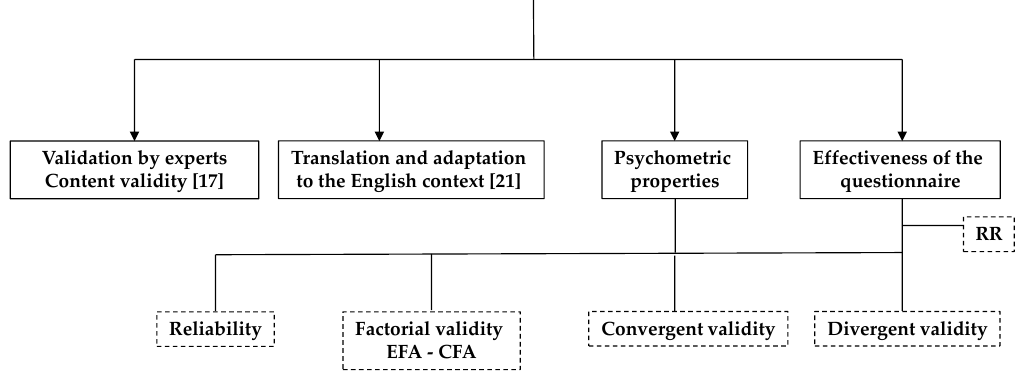
Figure 1. Study research design.